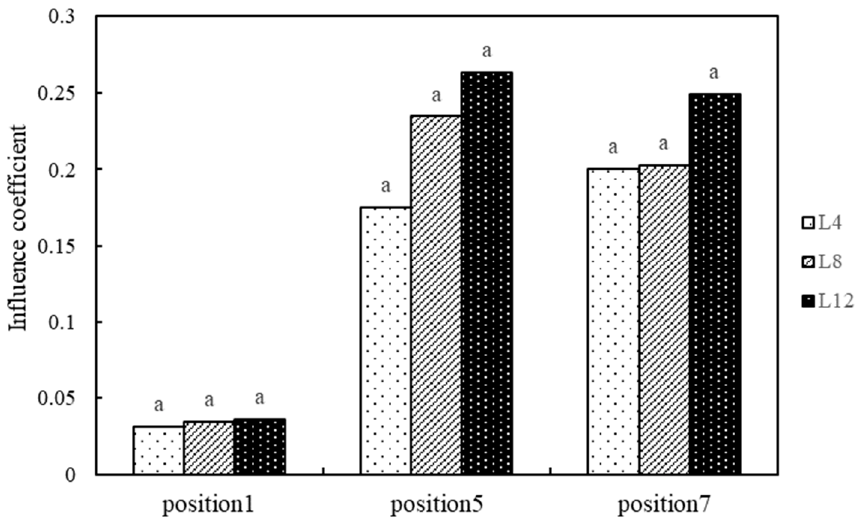
Figure 5. The influence coefficients at position 1, 5, and 7 (note: values within a position followed by the same letter are not significantly different (LSD, p < 0.05)).